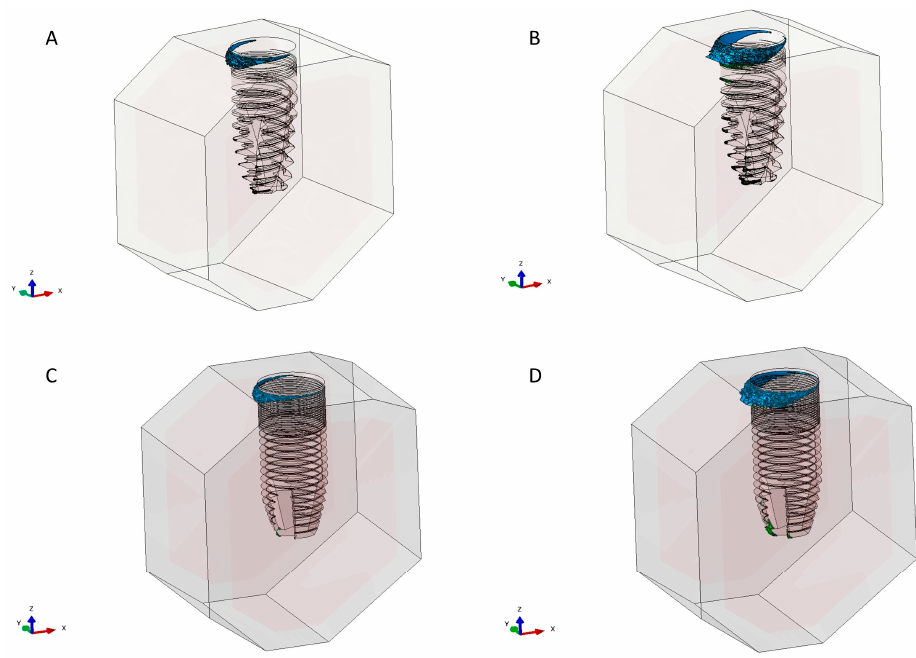
Figure 5. Progress of the contact surface loss between the cortical bone and the implant surface over the 10-year period. Bone loss at 5 and 10 years for the M-12 implant ( A , B ) and Astra implant ( C , D ).